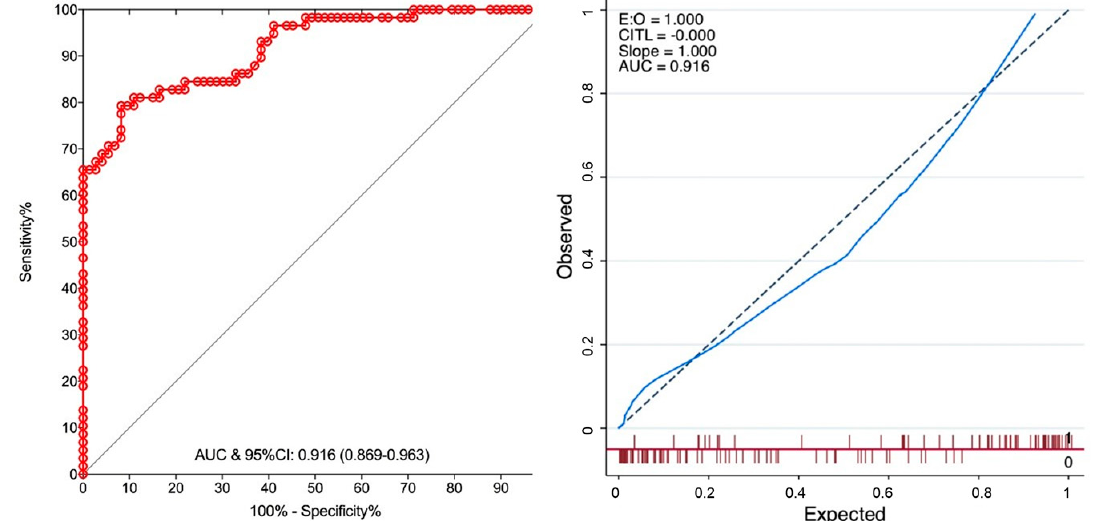
Figure 5. Receiver operating characteristics (ROC) curves of the regression model with the corresponding calibration curve showing adequate discrimination (AUC=0.916) and good calibration, with calibration slope of 1 and calibration in the large (CITL) of 0, indicating that the predicted prevalence of complexity was in keeping with the observed prevalence (CITL) and that the model was not over fitted (slope).